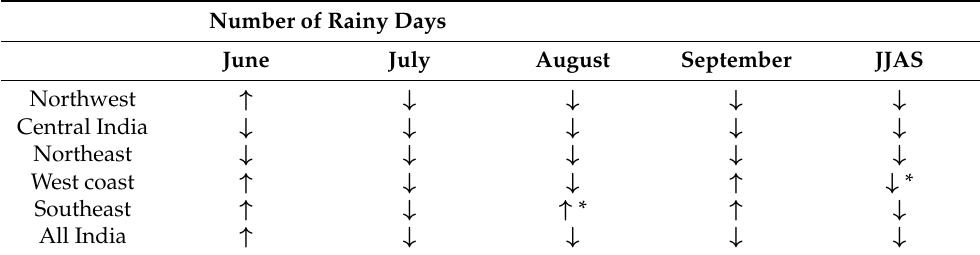
Table 1. Trends in the number of rainy days from 1985 to 2018, where “*” shows the significant trends at 95%. The up/down arrows show increasing/decreasing trends.